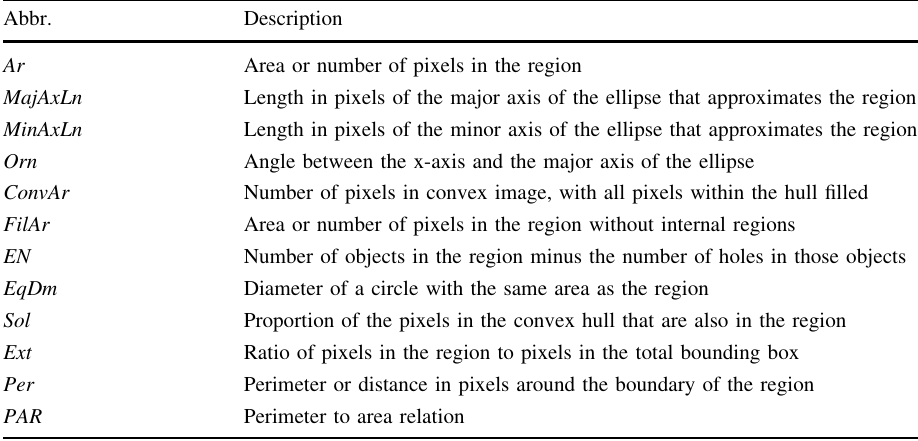
Table 1 The measured properties and their